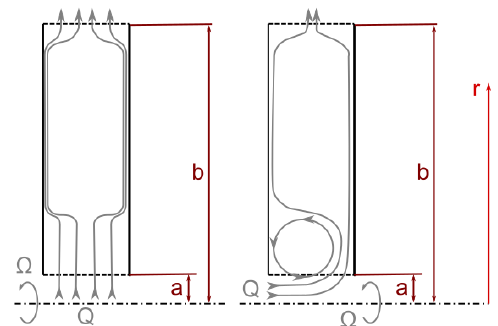
Figure 7. Different directions of inflow